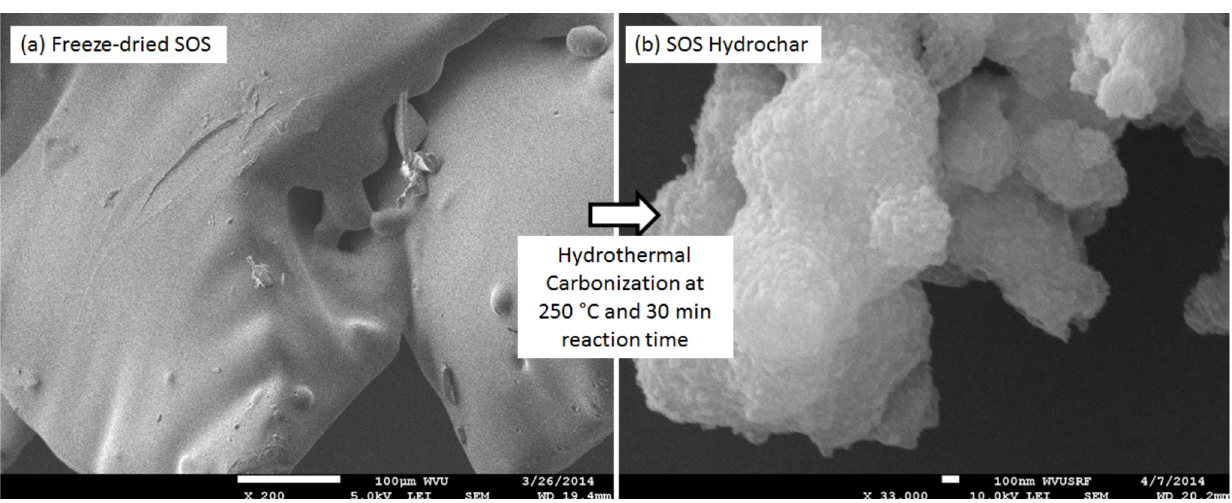
Figure 4. SEM pictures of ( a ) freeze-dried SOS sample ( b ) hydrochar made from SOS through hydrothermal carbonization at 250 °C with 30 min of reaction